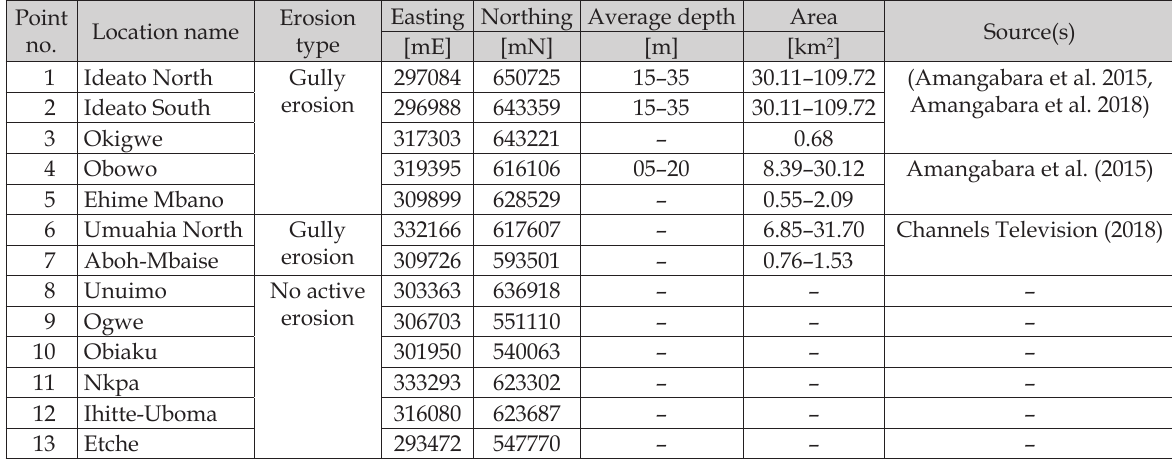
Table 2. Descriptive information of the validation points.